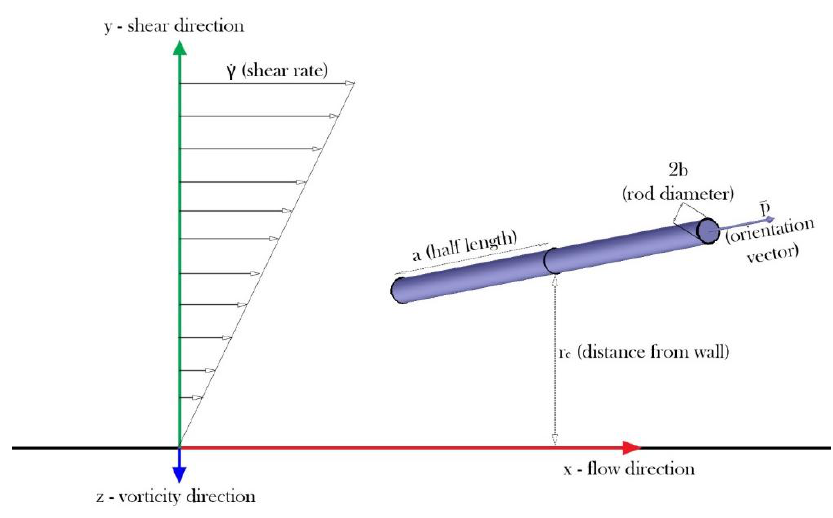
Figure 1. Schematic diagram of a rod under shear flow near a wall.